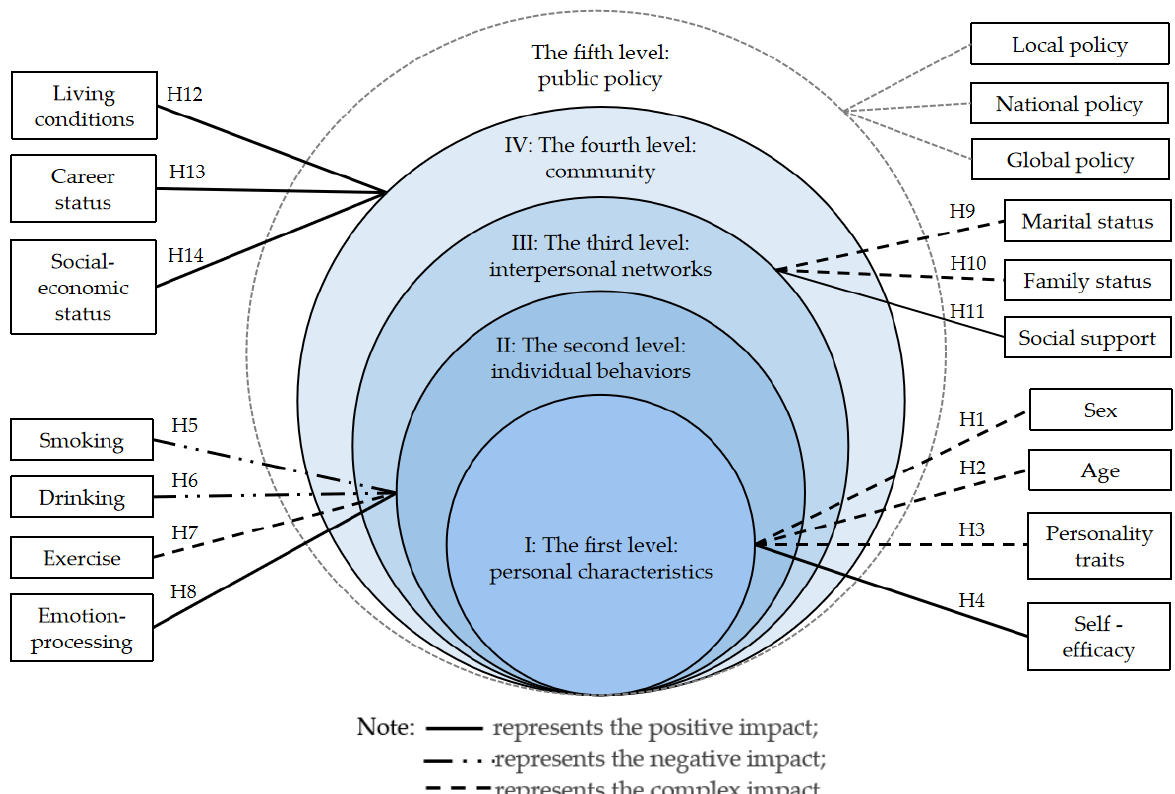
Figure 1. The Ecological Model of Health Behavior and thirteen research hypotheses.